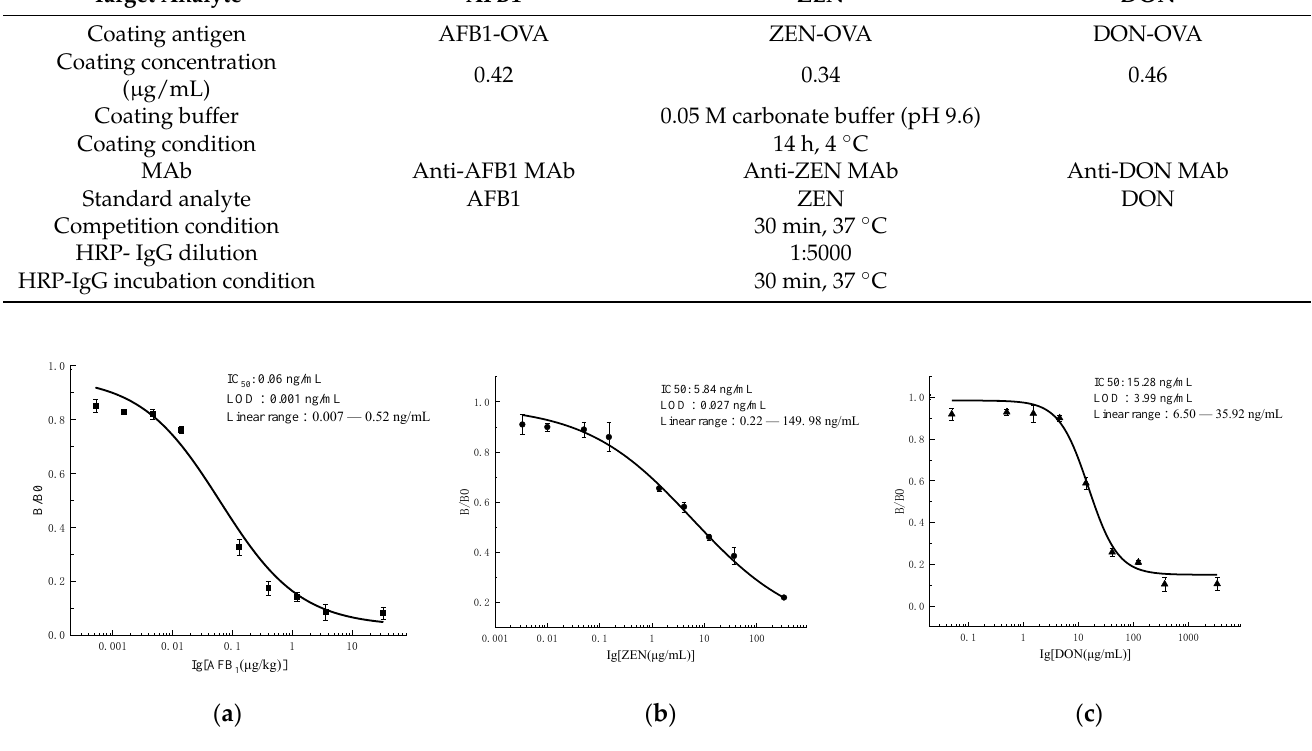
Figure 4. The inhibition curve of ic-ELISA: ( a ) AFB1; ( b ) ZEN; ( c ) DON (AFB1-OVA, ZEN-OVA, and DON-OVA were diluted and added to the wells of microtiter plates, and the coating buffer was 0.05 M carbonate buffer (pH 9.6). The reaction was carried out using 50 μL of MAb and HRP- IgG (1:5000) at 30 min, 37 °C).